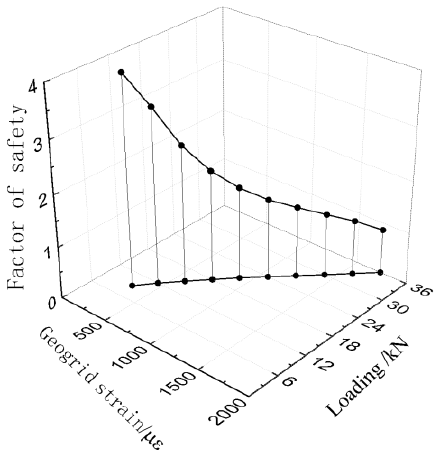
Figure 10. Relationship between loading, characteristic maximum strain, and the factor of safety.